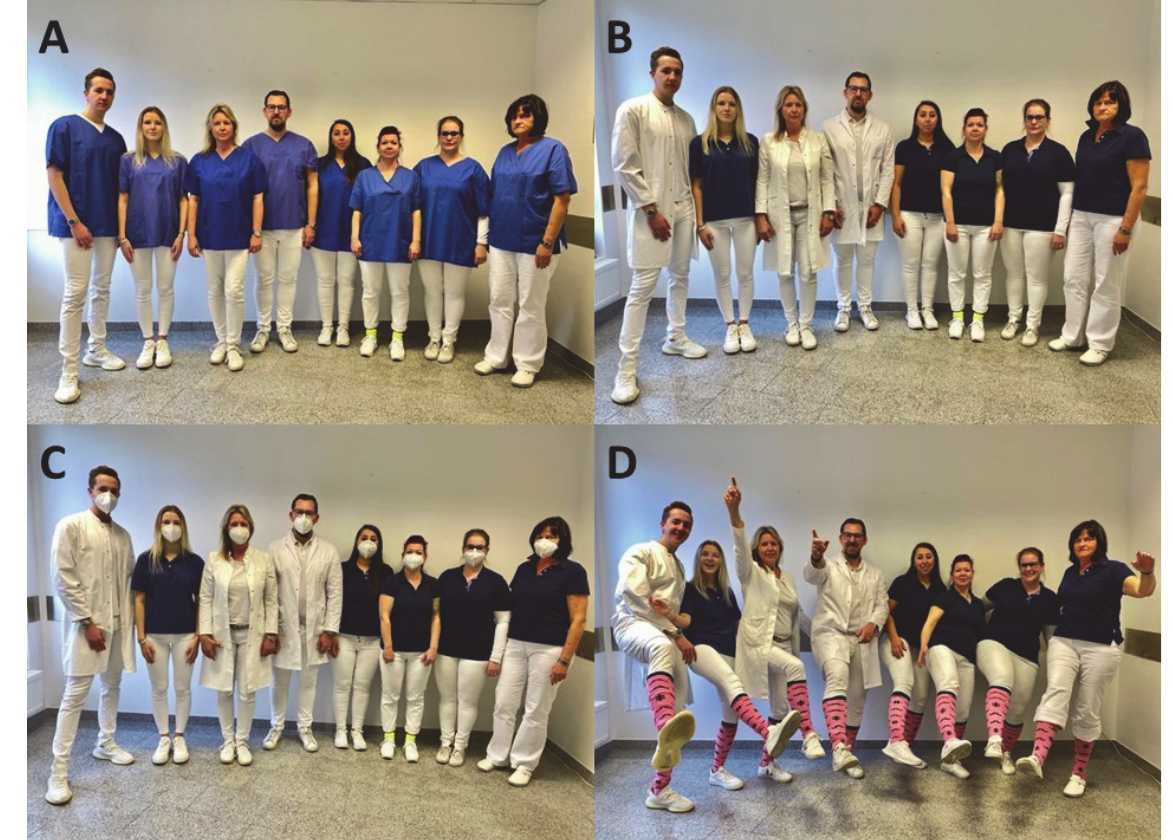
Figure 1. ( A ) All members of the practice team in white trousers with a blue tunic as a top. ( B ) Team members either in white trousers, white polo shirt, and white coat, or in whiter trousers and blue polo shirt ( C ) Team as in the second photo, but with additional FFP2 protective mask. ( D ) Team in a relaxed mood with #pinksocks as an additional accessory.